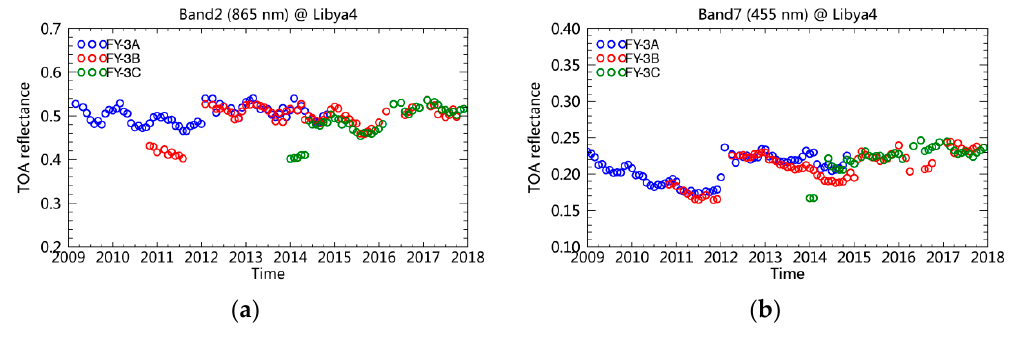
Figure 1. Time series of the nadir (viewing angle within 10°) ( a ) band 2 and ( b ) band 7 reflectance over Libya 4 from January 2009 to December 2017.